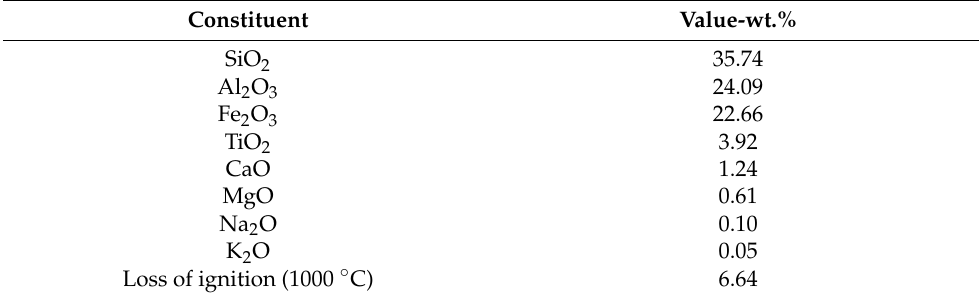
Table 1. Chemical characteristics of weathered